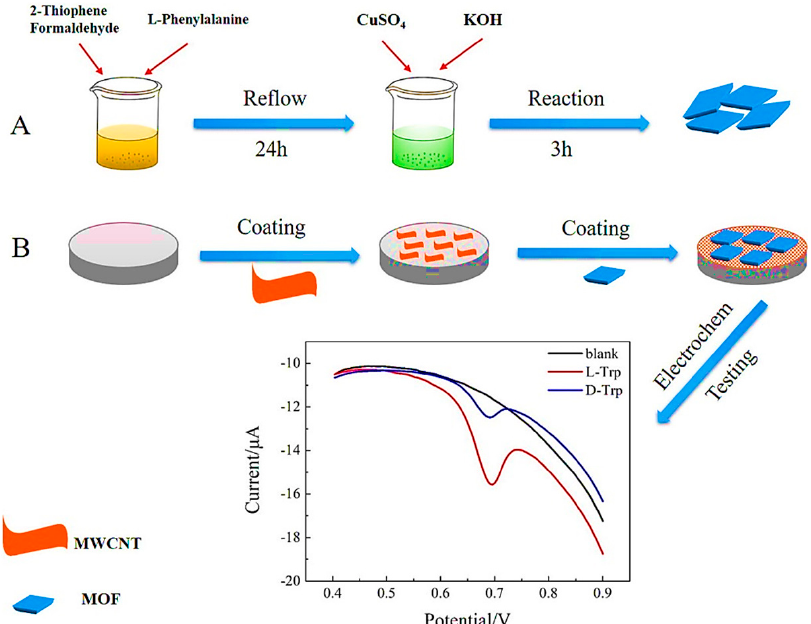
Figure 8. Representation of grain-CMOF/MWCNT interface for electrochemical enantiorecognition of tryptophan. Reprinted (adapted) with permission from [87].